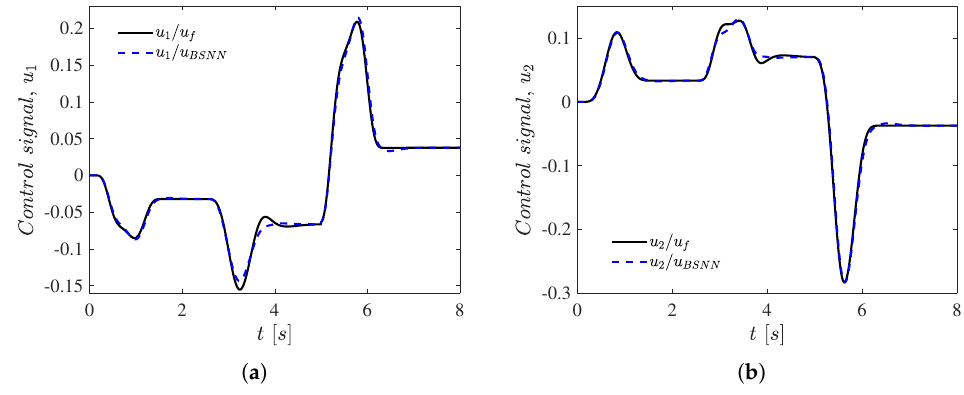
Figure 11. Control signals: ( a ) u 1 ; ( b ) u 2